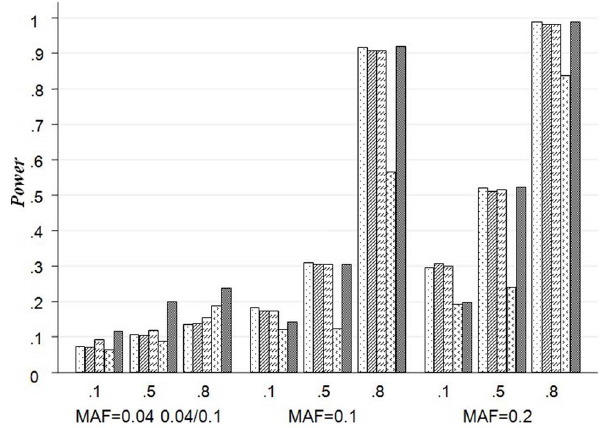
Figure 3. Test of Power for LKM, PCA and wPCA in Scenarios A7–A9. The plot shows the powers (y-axis) based on virtual datasets with two causal SNPs of each method over the different LD and MAF structures (x-axis) with 20 SNPs. The first line of x-axis represents LD, and the bottom line is MAF.